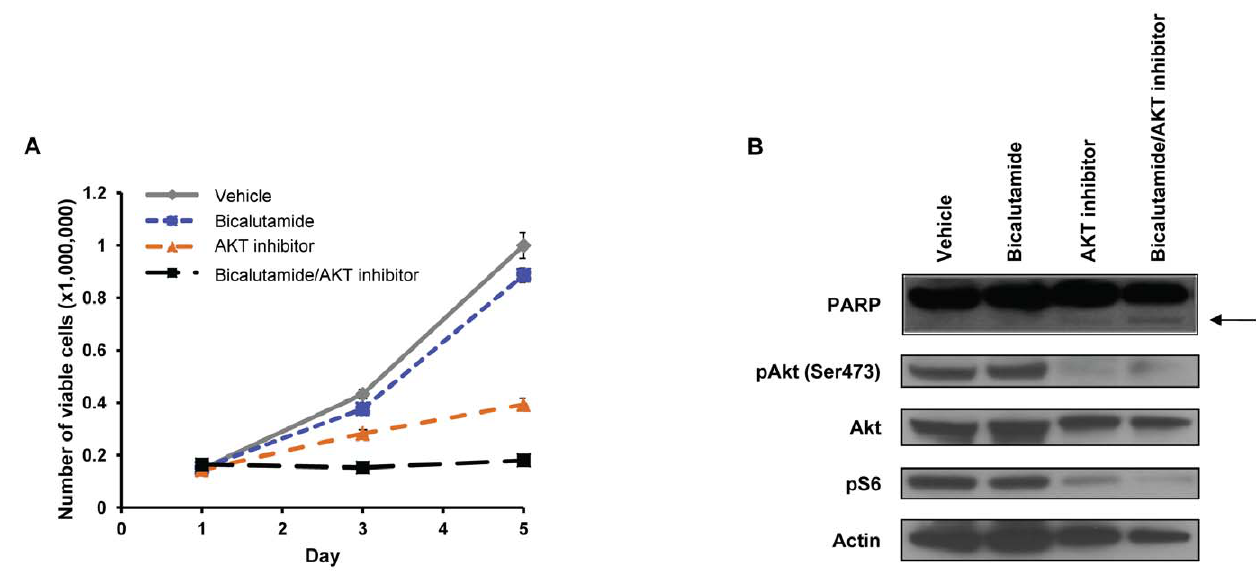
Figure 4. Akt1/2 inhibitor cooperated with bicalutamide to induce LNCaP cell apoptosis. (A) Number of viable LNCaP cells treated over 5 days with vehicle, bicalutamide (1 uM), Akt1/2 inhibitor (1 uM), or a combination of bicalutamide and AKT inhibitor. (B) Apoptosis was measured in LNCaP cells by immunoblotting using a PARP antibody in LNCaP cells treated as in (A). Inhibition of phosphorylated Akt (pAkt (Ser473)) and phosphorylated S6 (pS6) was also measured. Actin was used as a loading control.